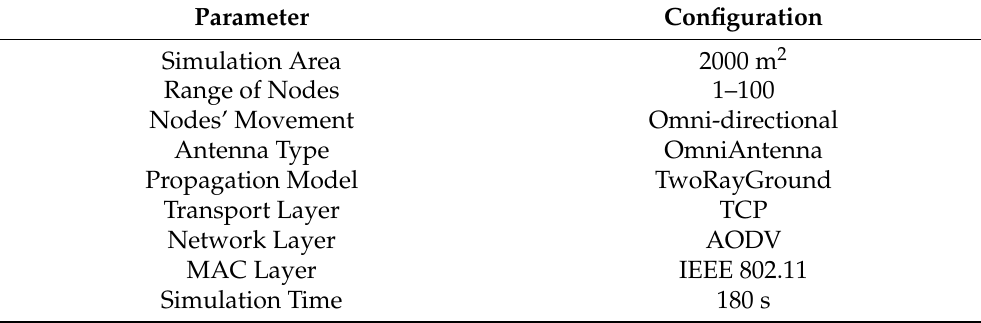
Table 4. Simulation